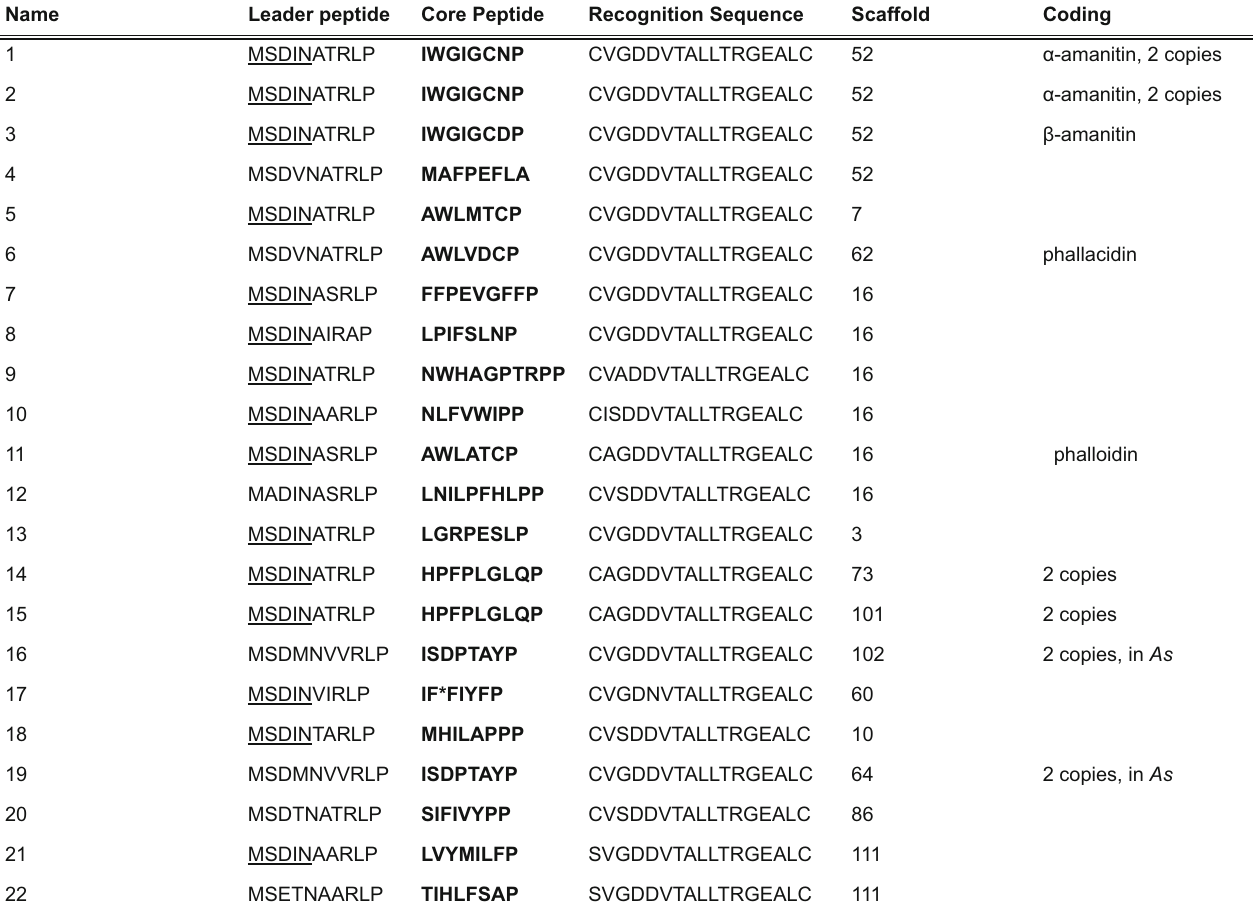
Table 3. MSDIN peptide sequences from Amanita pallidorosea ( Apa ).